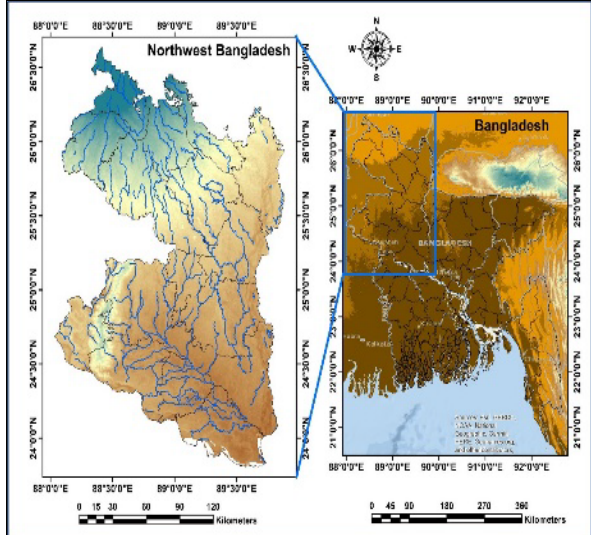
Figure 1 . Northwest